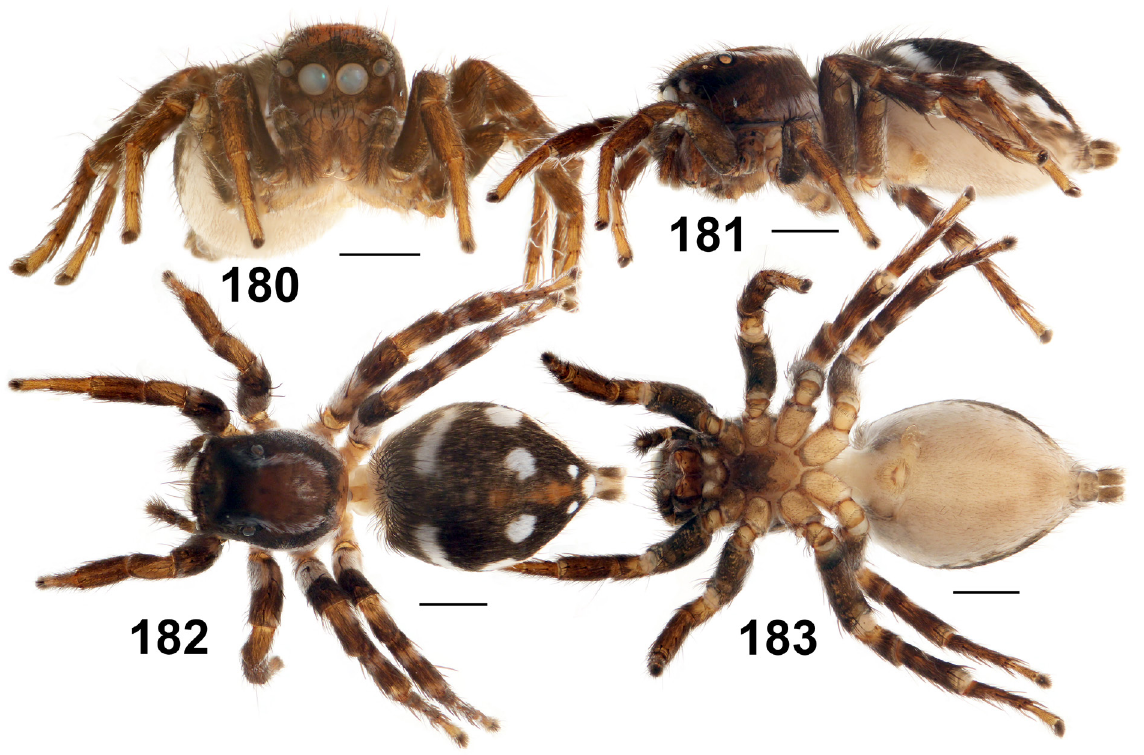
Figs 180–183. Stenaelurillus guttatus (Wesołowska & Cumming, 2002) comb. nov., ♀, from Botswana (near Francistown; NCA 2007/573), general appearance. Scale bars: 1